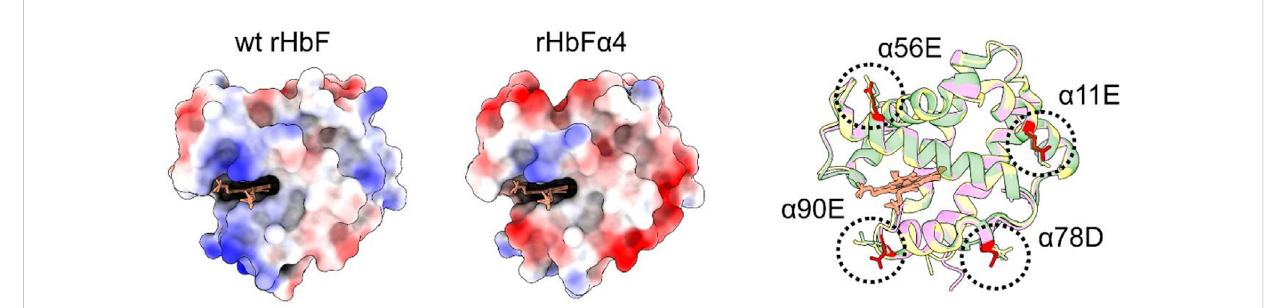
FIGURE 4 [IN COLOR] The α -subunits of the wt and mutant HbF structures are shown with electrostatic surface coloring. Blue color indicates positive charge and red color indicates negative charge. To the right, three different HbF α -subunit structures, one from this work (rHbF α 4 purple)and two from the PDB database(1FDH(SomanandOlson,2013)yellow,4MQJ(Miklosetal.,2012)green),arethree-dimensionallyalignedwiththepeptidebackbonesshownas ribbons.ThemutationsitesoftherHbF α 4mutantarecoloredinredforclari fi cation.All3Dstructuresofthe α -subunitinHbFalignandshowthatthe four mutations introduced on the protein in this work do not disrupt the globin